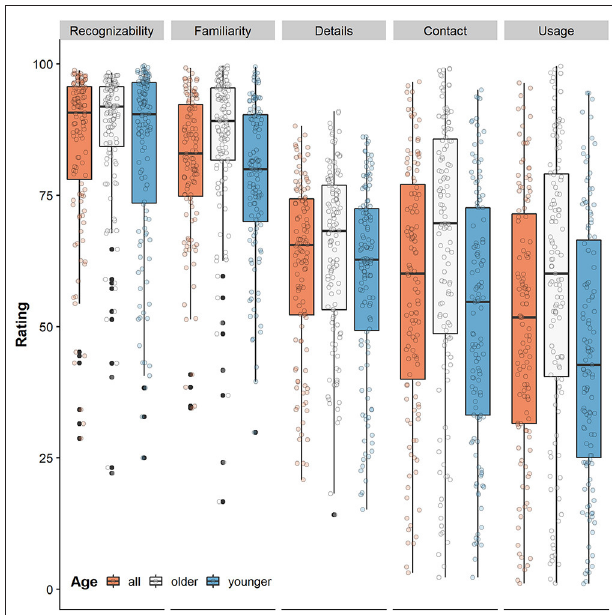
FIGURE 2 | Boxplots with individual data points for the object ratings for the entire sample (red) and per age group (older: white, younger: blue) per dimension (1 = not, 100 = very). The horizontal line represents the median.